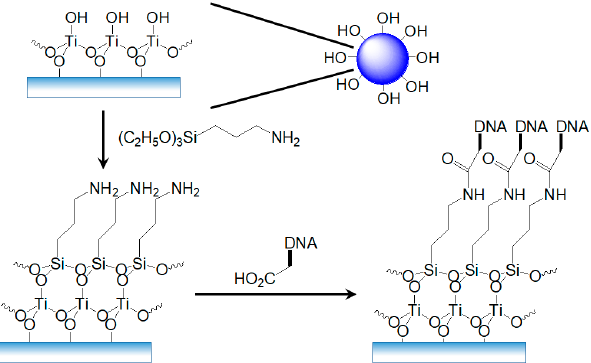
Scheme 1. Schematic diagram of the silanization of TiO 2 NPs and the immobilization of DNA on silanized TiO 2 NPs.